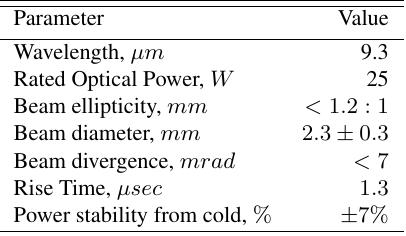
Table 1. Main characteristics of Iradion® Infinity CO 2 laser